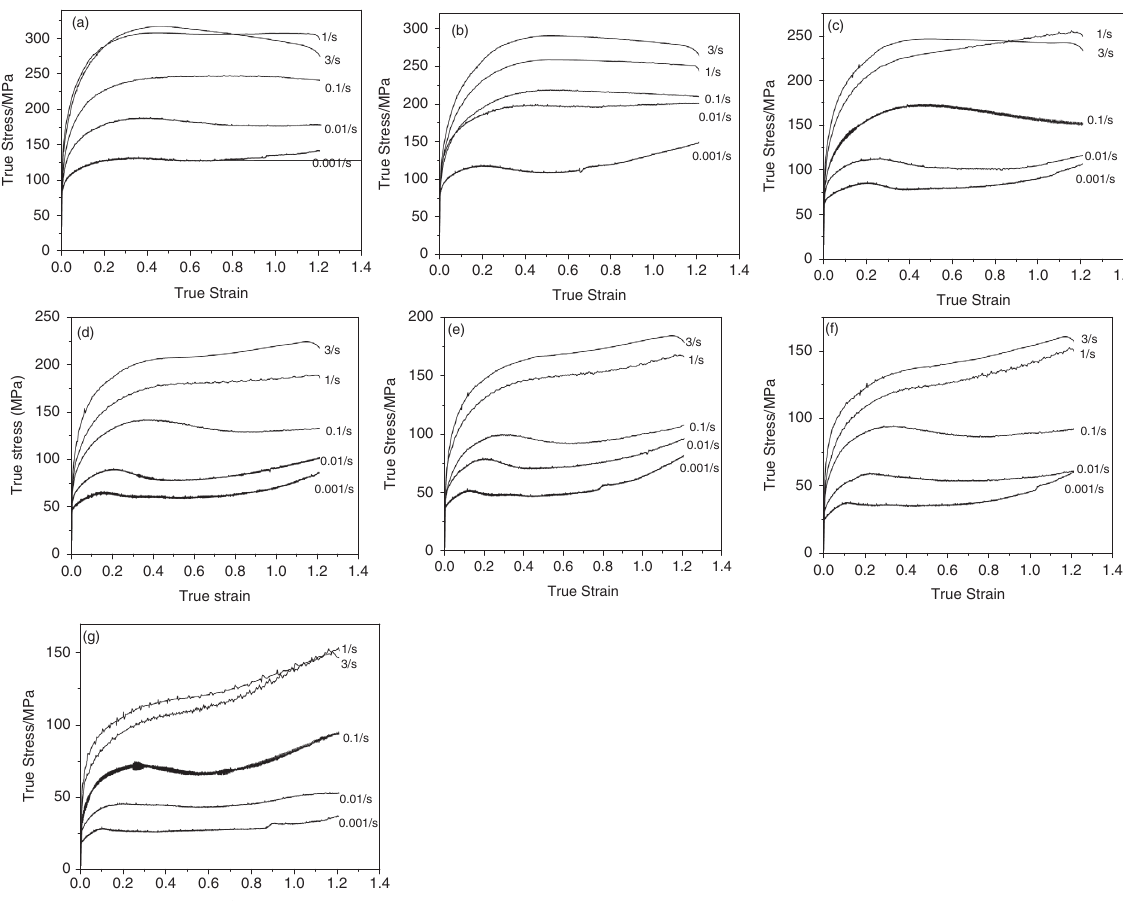
Figure 1: The stress – strain curve under different testing conditions: (a) 900°C; (b) 950°C; (c) 1,000°C; (d) 1,050°C; (e) 1,100°C; (f) 1,150°C; (g)